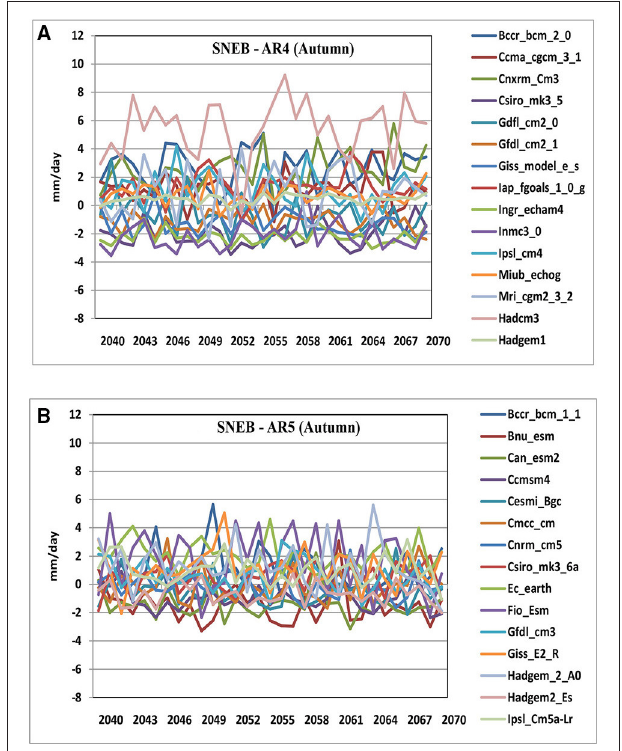
FIGURE 13 | Summer rainfall anomalies projected for southern NNB from CMIP3-AR4 (A) and CMIP5-AR4 (B) models over the period 2040-2070.